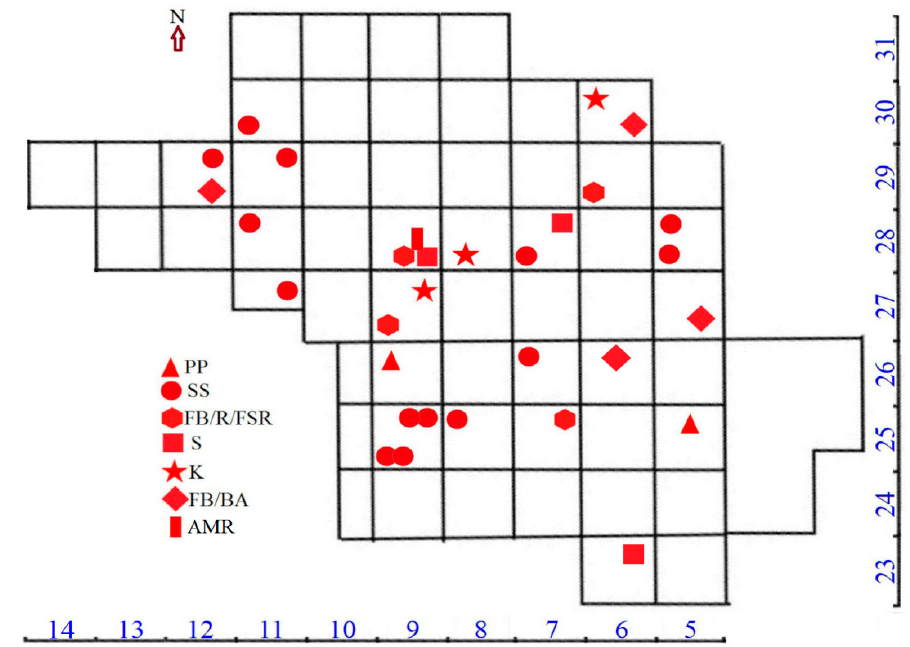
Figure 12. Distribution of the PA artifacts in the main excavation. The detail of each piece is given in Table 2.